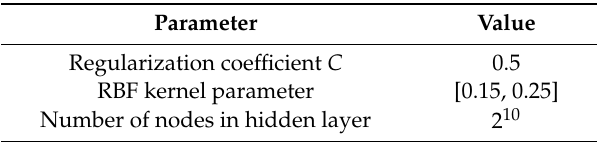
Table 12. Improved extreme learning machine algorithm optimized by RBF kernel function (RELM) model parameter set.